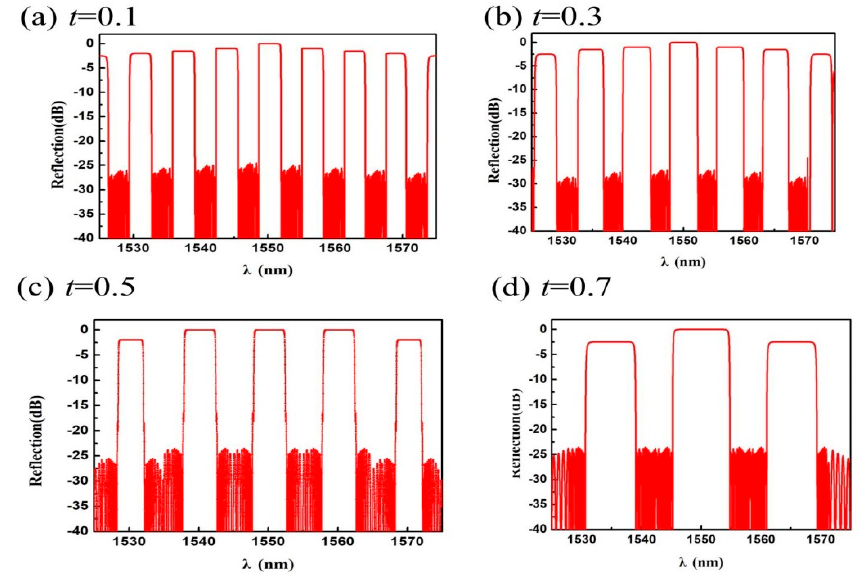
Figure 7. Reflection spectrum of the proposed apodized sampled grating related to t when N = 5. ( a ) t = 0.1; ( b ) t = 0.3; ( c ) t = 0.5; ( d ) t = 0.7.